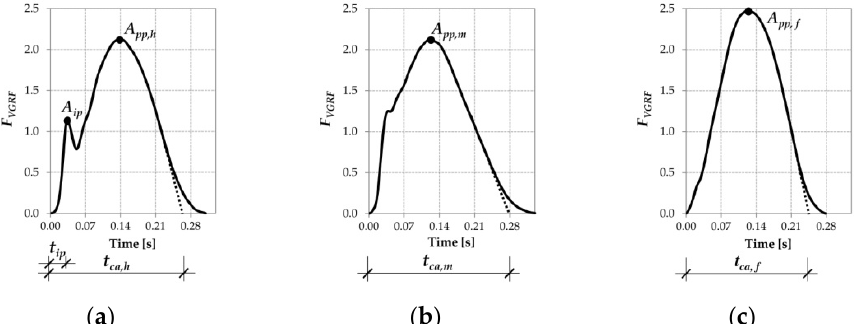
Figure 1. Examples of time courses of normalised ground reaction forces F VGRF for different foot-strike patterns for running frequency f r = 2.80 Hz: ( a ) heel-strike pattern, ( b ) midfoot-strike pattern, ( c ) forefoot-strike pattern (based on the author’s research results).